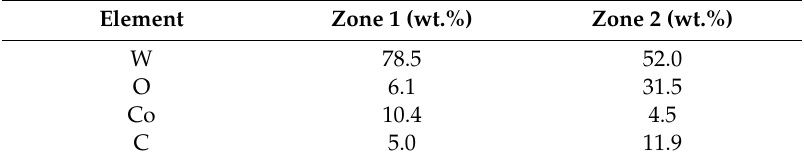
Table 5. Chemical composition in wt.% of di ff erent zones of the wear track of the 2LWC coating. Element